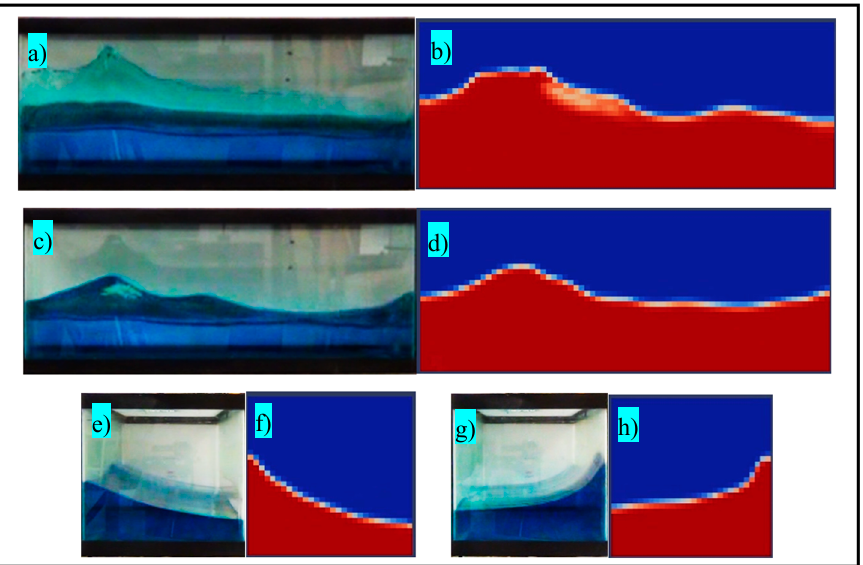
Figure 7. Qualitative comparison of liquid free surface in the experimental ( a , c , e , g ) and numerical ( b , d , f , h ) studies in the tank with 100 mm of water, 60° orientation, and frequency of higher than resonance.